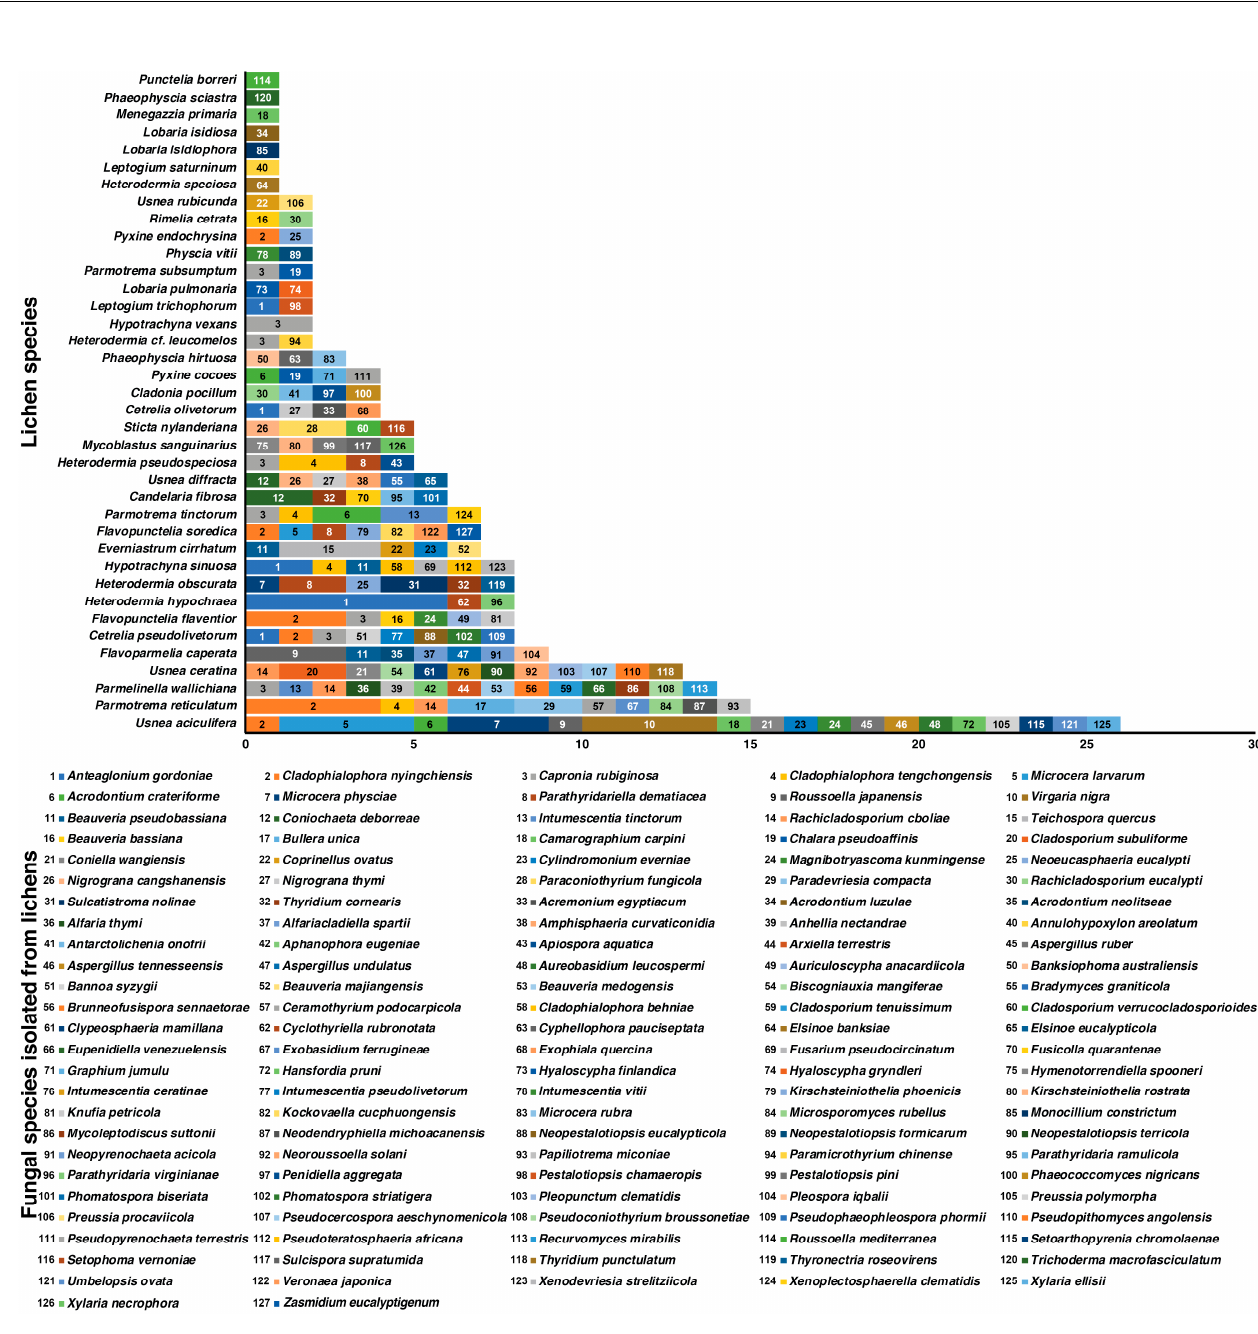
Figure 2. Fungi isolated from 38 lichen species sampled in this study from Yunnan Province, China, between 2020 and 2021. Fungal species are listed according to their abundance in lichens. Three most frequently isolated fungal species were Anteaglonium gordoniae (11 isolates), Cladophialophora nyingchiensis (11 isolates), and Capronia rubiginosa (nine isolates). Highest number of fungal isolates were recovered from the lichens Usnea aciculifera (26 isolates), Parmotrema reticulatum (15 isolates), Parmelinella wallichiana (14 isolates), and Usnea ceratina (13 isolates). The numbers within the bar-plot represent the fungal species.